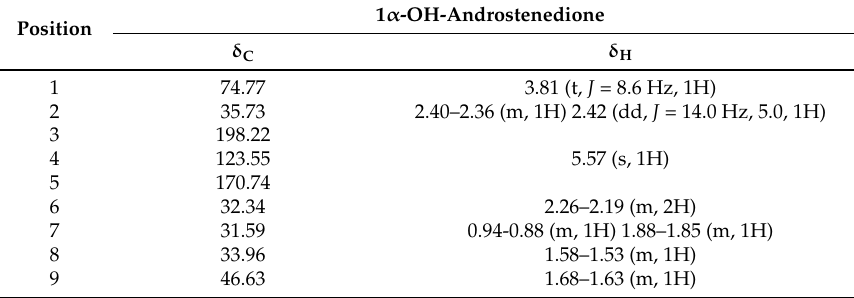
Table 3. NMR data for 1 α -OH-androstenedione (600 MHz for 1 H-NMR and 150 MHz for 13 C-NMR, DMF, J in Hz, δ in ppm).